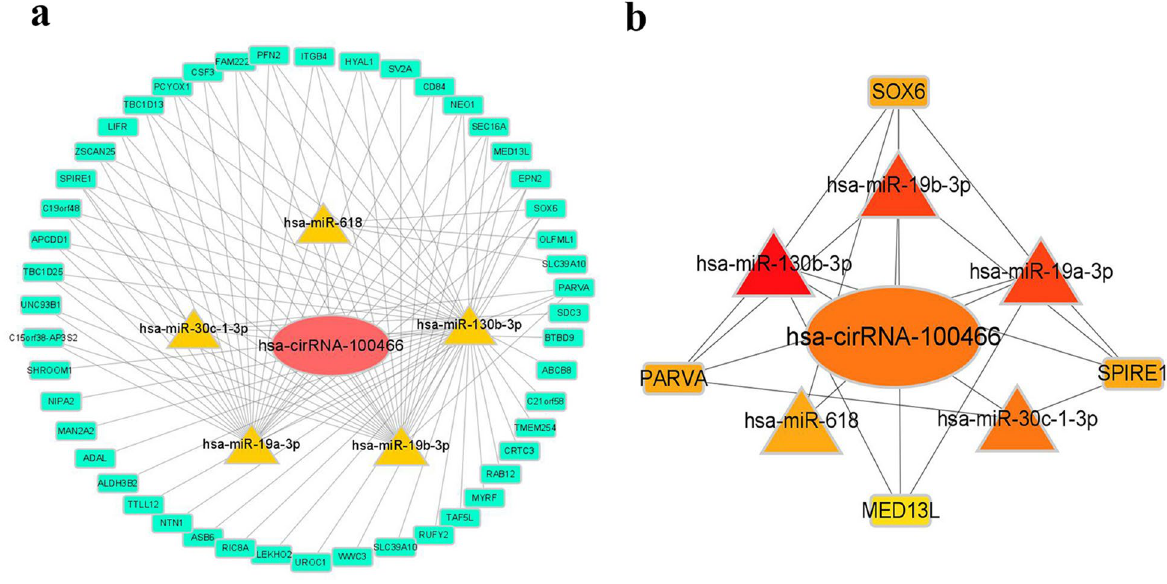
Figure 3. Hsa-circRNA-100466 serves as a sponge for multiple miRNAs. ( a ) Network of circRNA/miRNA/ mRNA interactions based on hsa-circRNA-100466. Red ellipse node, circRNA; yellow triangle